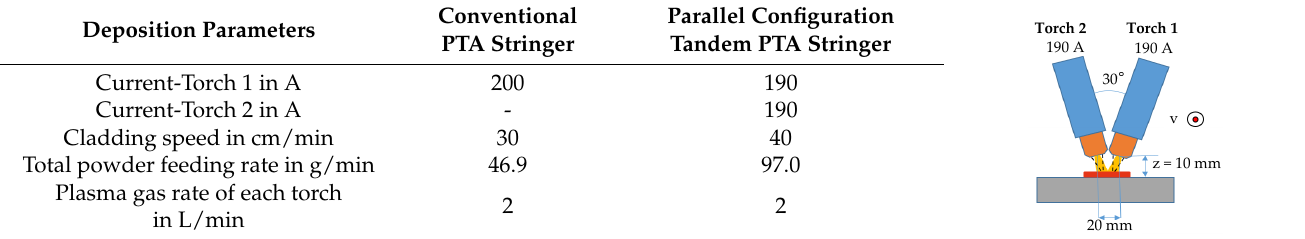
Table 6. Deposition parameters for high deposition additive manufacturing.